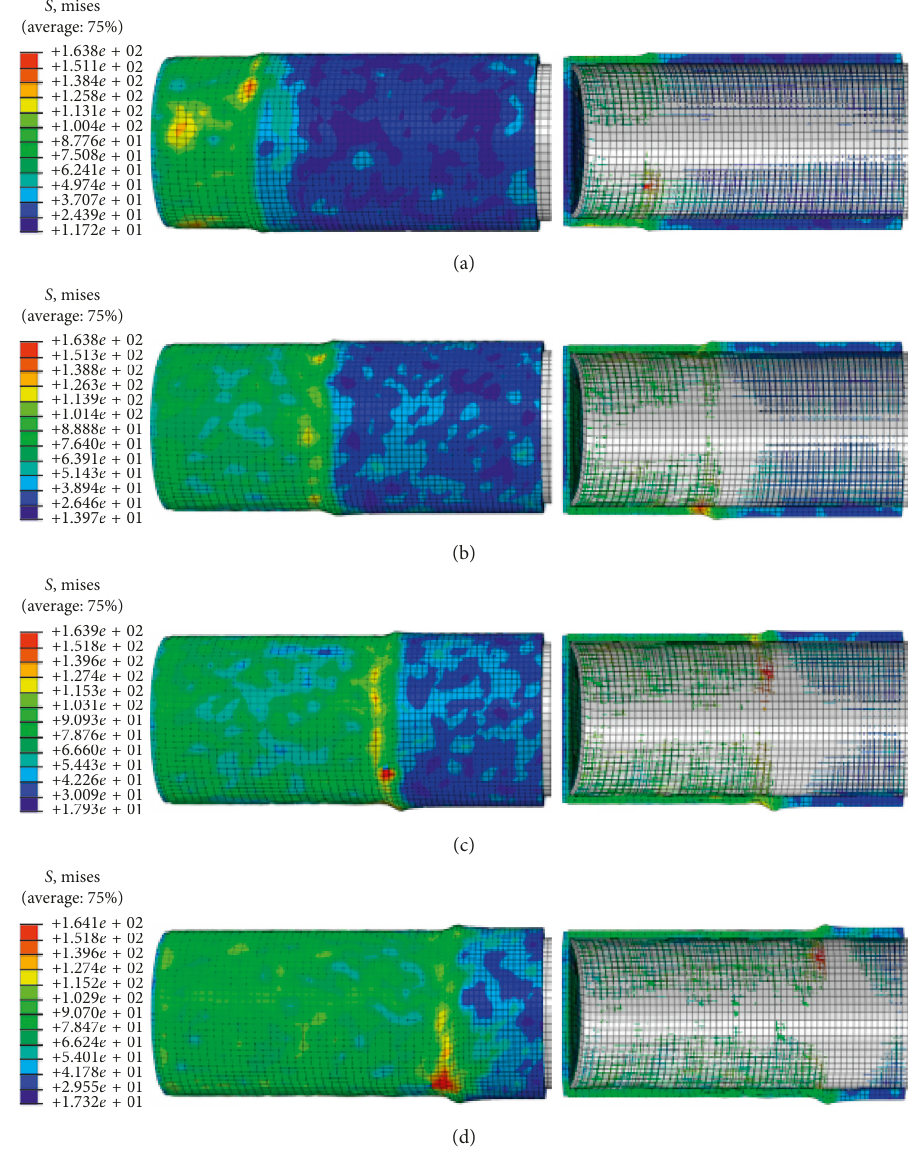
Figure 13: Fourth-pass equivalent stress distribution. (a) 25%. (b) 50%. (c) 75%. (d)